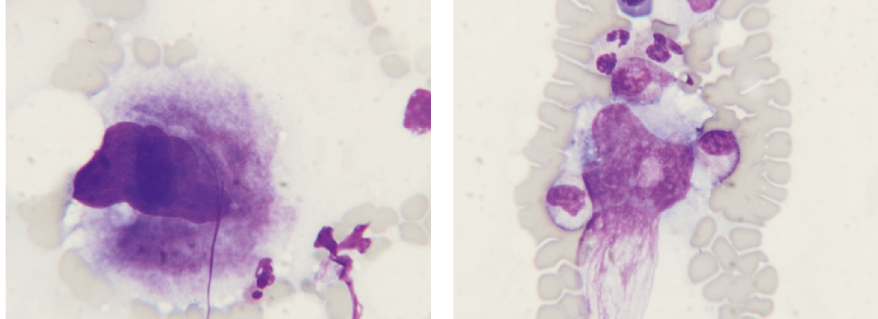
Figure 1: Bone marrow aspiration showed increased number of megakaryocytes, particularly those with hypolobulated nuclei. There was not any other abnormality in the bone marrow smear.